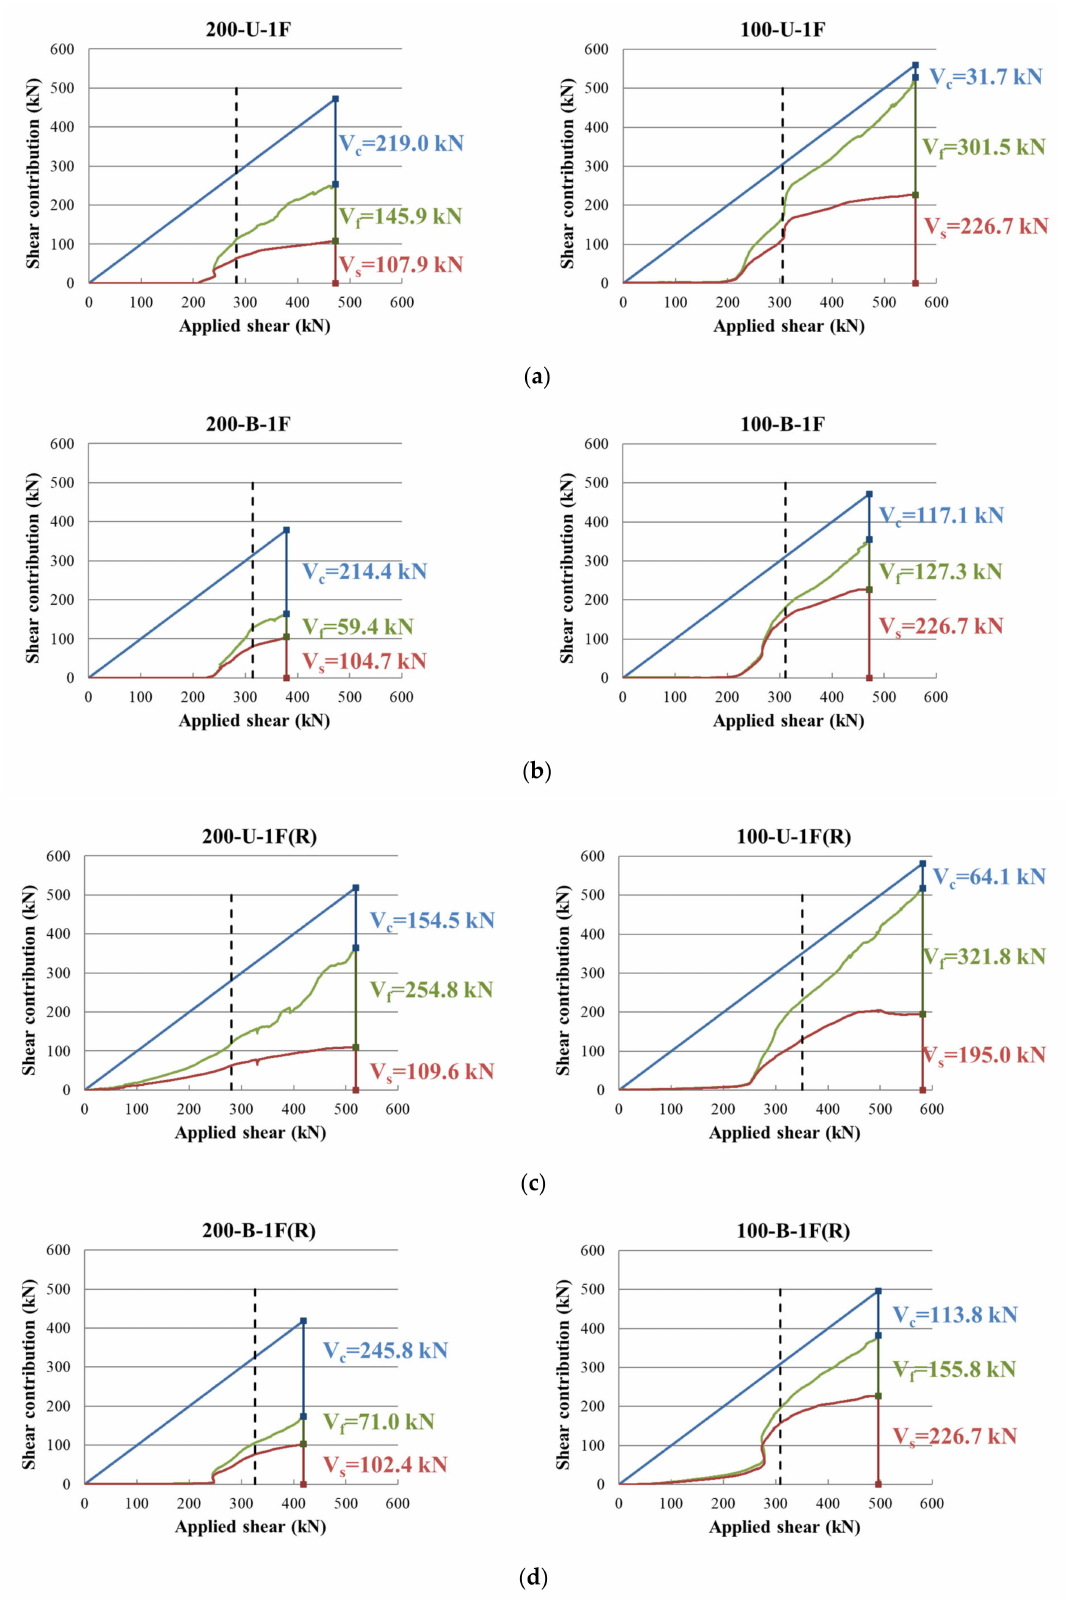
Figure 8. Measured shear contribution of concrete, stirrups and CFRP strips in first series of specimens: ( a ) 200-U-1F vs. 100-U-1F; ( b ) 200-B-1F vs. 100-B-1F; ( c ) 200-U-1F(R) vs. 100-U-1F(R); ( d ) 200-B-1F(R) vs.